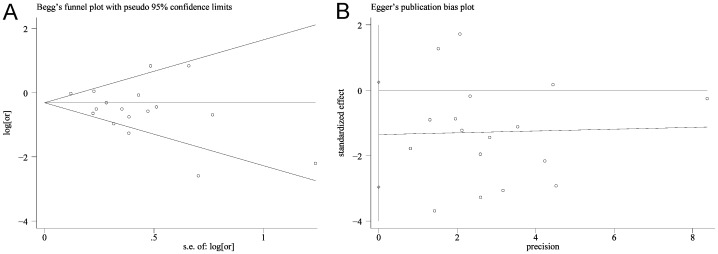
Begg's test and Egger's test.Begg's test and Egger's test identified no publication bias (Begg's test: Kendall's tau = −12, P = 0.65; Egger's test: bias = −1.36, P = 0.092).